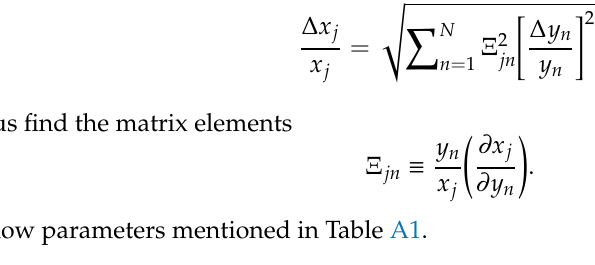
Table A1. The snow parameters retrieved from satellite observations ( y n = R n